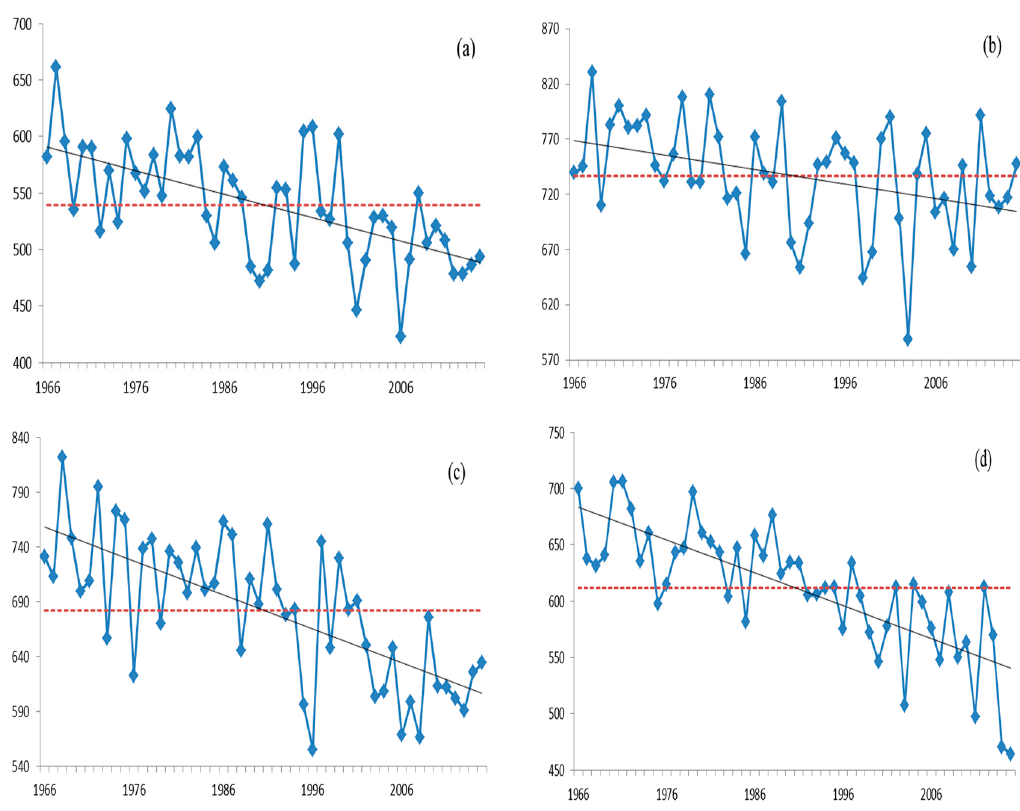
Figure 5. Variability of seasonal average sunshine duration(blue line) with the average (red line) and linear trend (black line) in the Haihe River basin during 1966–2015: ( a ) Winter; ( b ) Spring; ( c ) Summer; ( d ) Autumn.